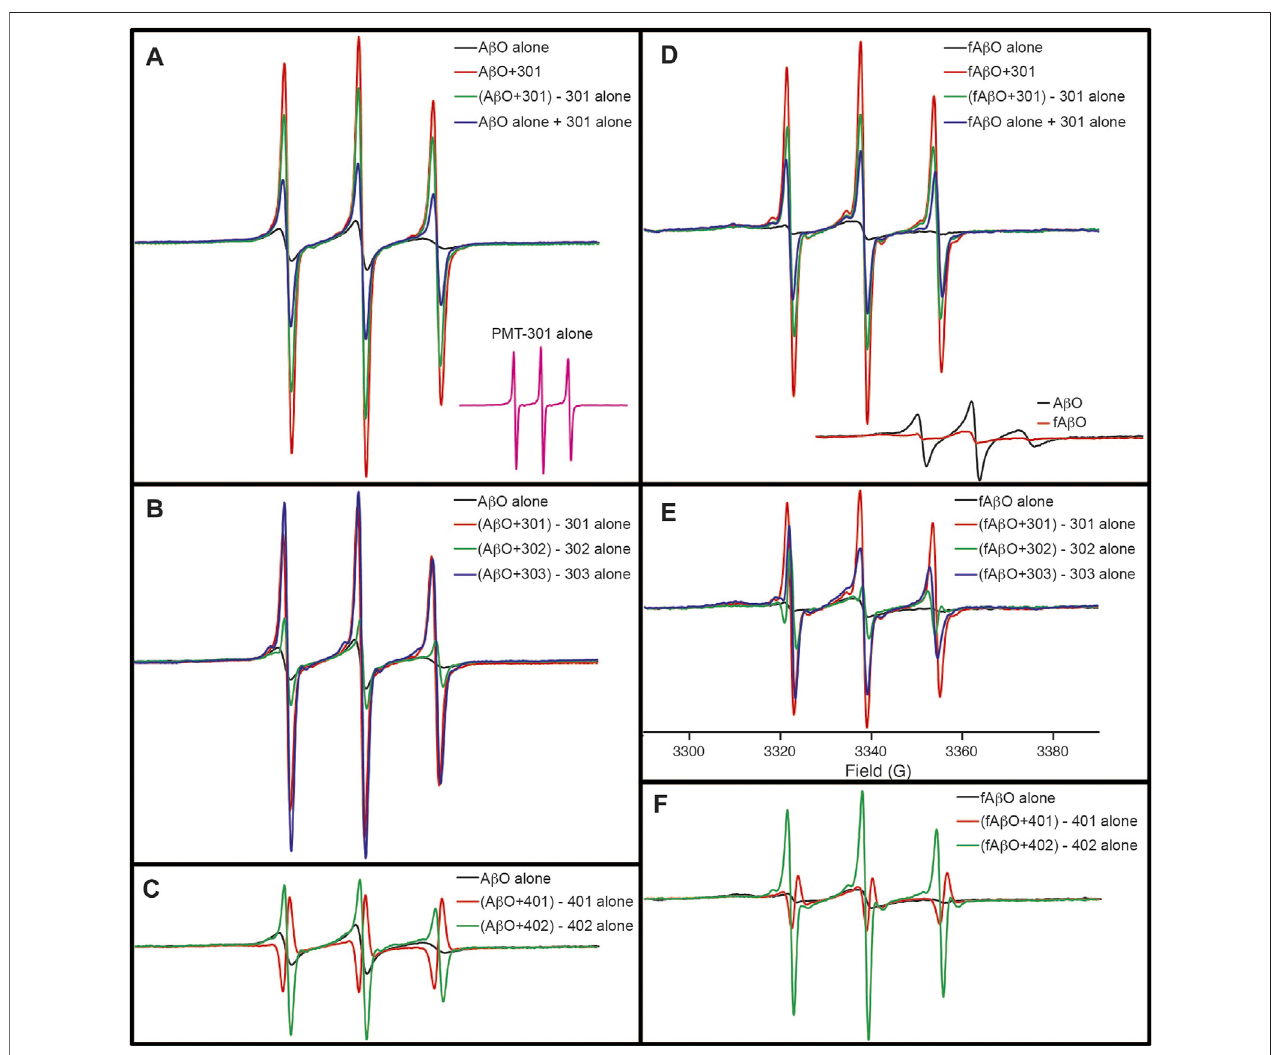
FIGURE7| EPRspectrashowingthehowPALsaltertheorderwithinA β O.ShownareX-bandEPRspectraofA β O TOAC withandwithoutPALtreatment.Theblack trace in panel (A) shows the broad spectrum of the TOAC label within A β O, re fl ecting a local region of order and a close proximity to other TOAC labels. In contrast, the EPRspectrumofthePMT301PALalonedisplaysanarrowlineshapeowingtotherapidrotationalmotionofthefreesmallmoleculeinsolution[ (A) ,inset].Uponaddition of PMT301 to A β O, a composite spectrum is obtained [red trace in (A) ]. The effect of the PAL agent on the isolated A β O signal can be observed by subtracting the spectrum of free PMT301 from the composite A β O + PMT301 spectrum to produce the resulting PAL-modi fi ed A β O spectrum [green trace in (A) ]. The increased amplitude of the green spectrum in panel A re fl ects a decrease in the TOAC spin label order following PMT301 treatment. The conformational effect of PMT301 is also evident when comparing the experimental composite spectrum (red trace) to the calculated sum of the two samples alone [blue trace in panel (A) ]. (B,C) show the comparative effects of each PAL on A β O. In (B,C) the untreated A β O spectrum (black trace) is compared to the sample after subtraction of the PAL-alone (free PAL) component. (D – F) show the results of similar measurements on the proto fi bril A β O (fA β O) sample. A comparison of A β O to fA β O is shown in the inset of (D) . fA β O displays a broader EPR spectrum than A β O, re fl ecting the increased order and spin coupling found in the proto fi bril sample. Notably, subtraction of the free PMT401 component from the composite A β O and fA β O spectra results in spectra with inverted amplitudes [red traces in (C,F) ]. This fi nding reveals evidence of spin coupling betweenthePMT401nitroxylmoietyandtheTOAClabelonA β (i.e.,thePMT401contributionissubstantiallybroadenedinboththecompositeA β O+401spectrumand fA β O + 401 spectrum. Except for the inset spectra in (A,D) , spectral intensities represent stoichiometric amounts of A β O TOAC and PAL agent (both at 80 μ M). The spectral amplitudes of each panel are normalized to the same amount of A β O TOAC , and all spectra were collected over 100 G [ fi eld sweep axis displayed in (E) ].